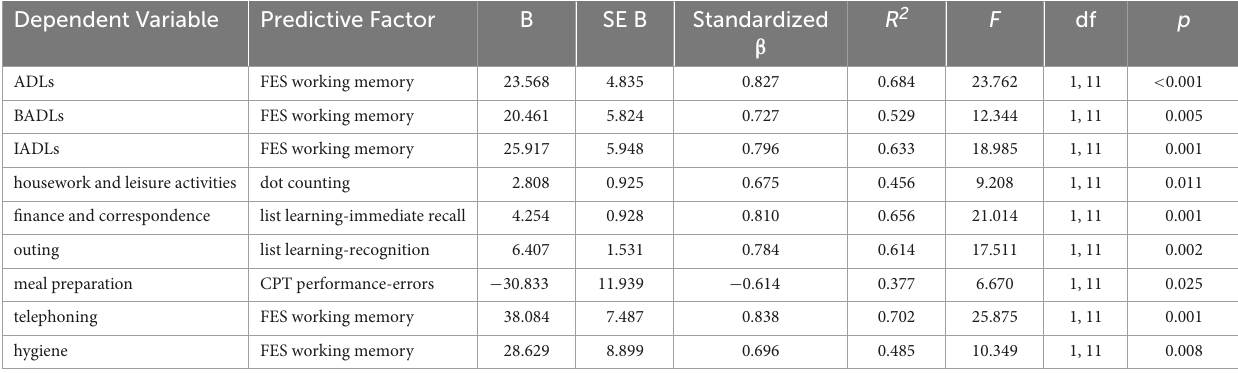
TABLE 1 Summary of the second set of stepwise regression analyses regarding neuropsychological tests with the greatest contribution to each functional domain, as assessed by the DAD ratings.